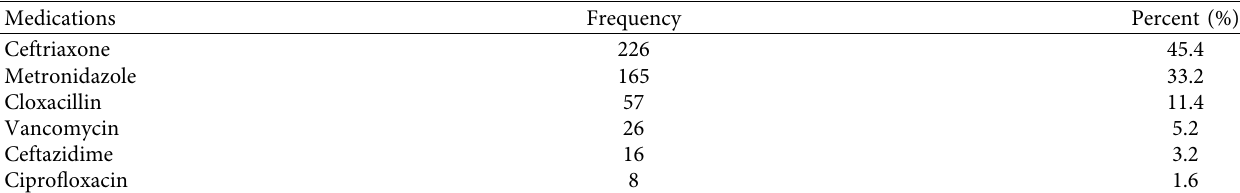
Table 2: SEQ Table \ ∗ ARABIC Types of prescribed medications at the University of Gondar Comprehensive and Specialized Hospital from October 3 to November 14, 2021 ( n �